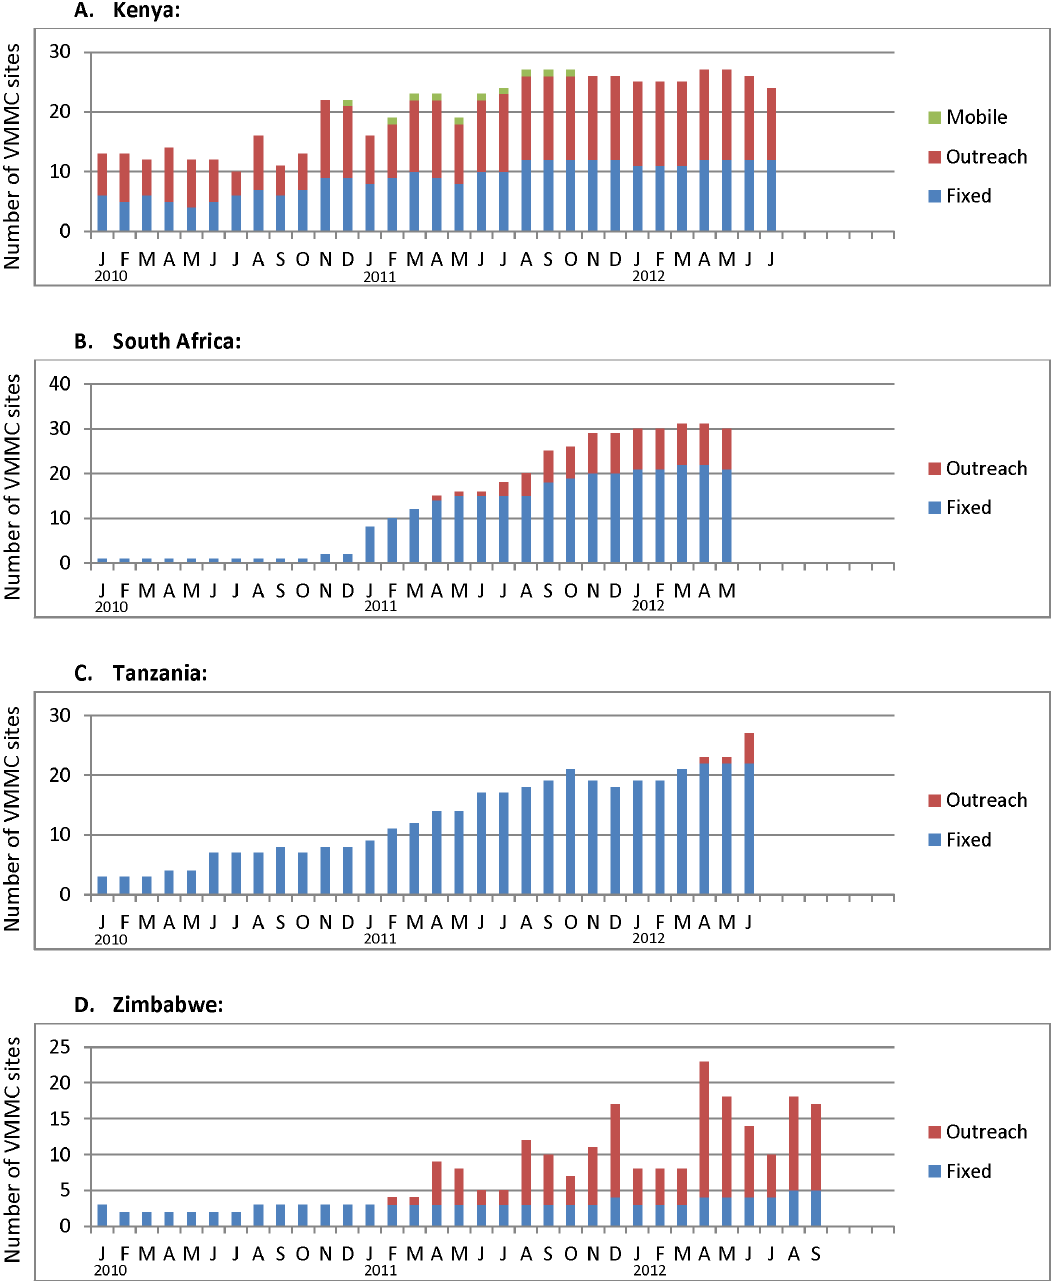
Figure 1. Number of operational VMMC sites by month, type of site, and country, January 2010 - mid 2012. In this and all figures following, ‘‘Kenya’’ refers to Nyanza Province